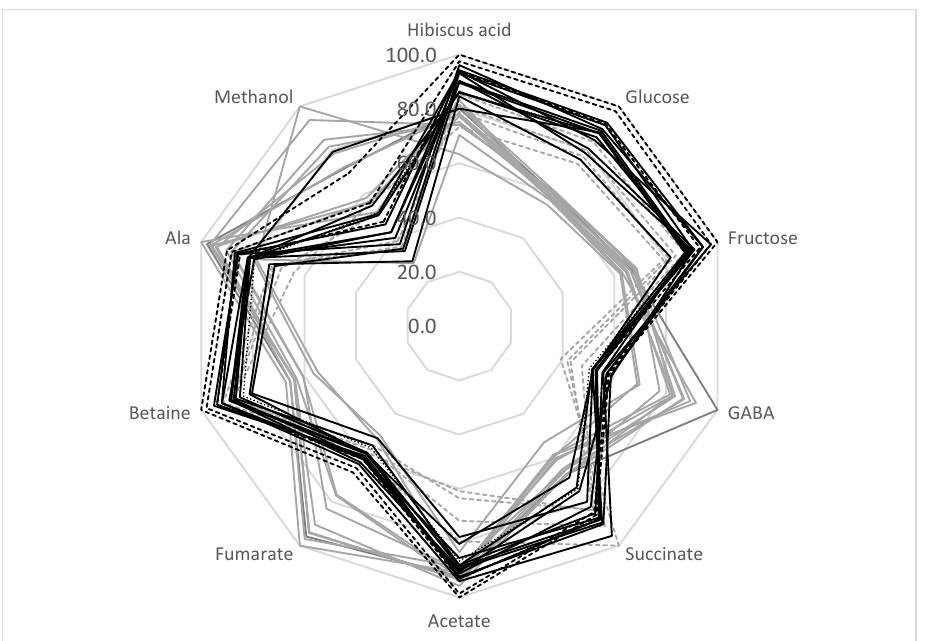
Figure 3. Comparison of H. sabdariffa calyx samples (%). Grey: SD; black: TD. Samples 13 – 16 are shown in dashed lines.